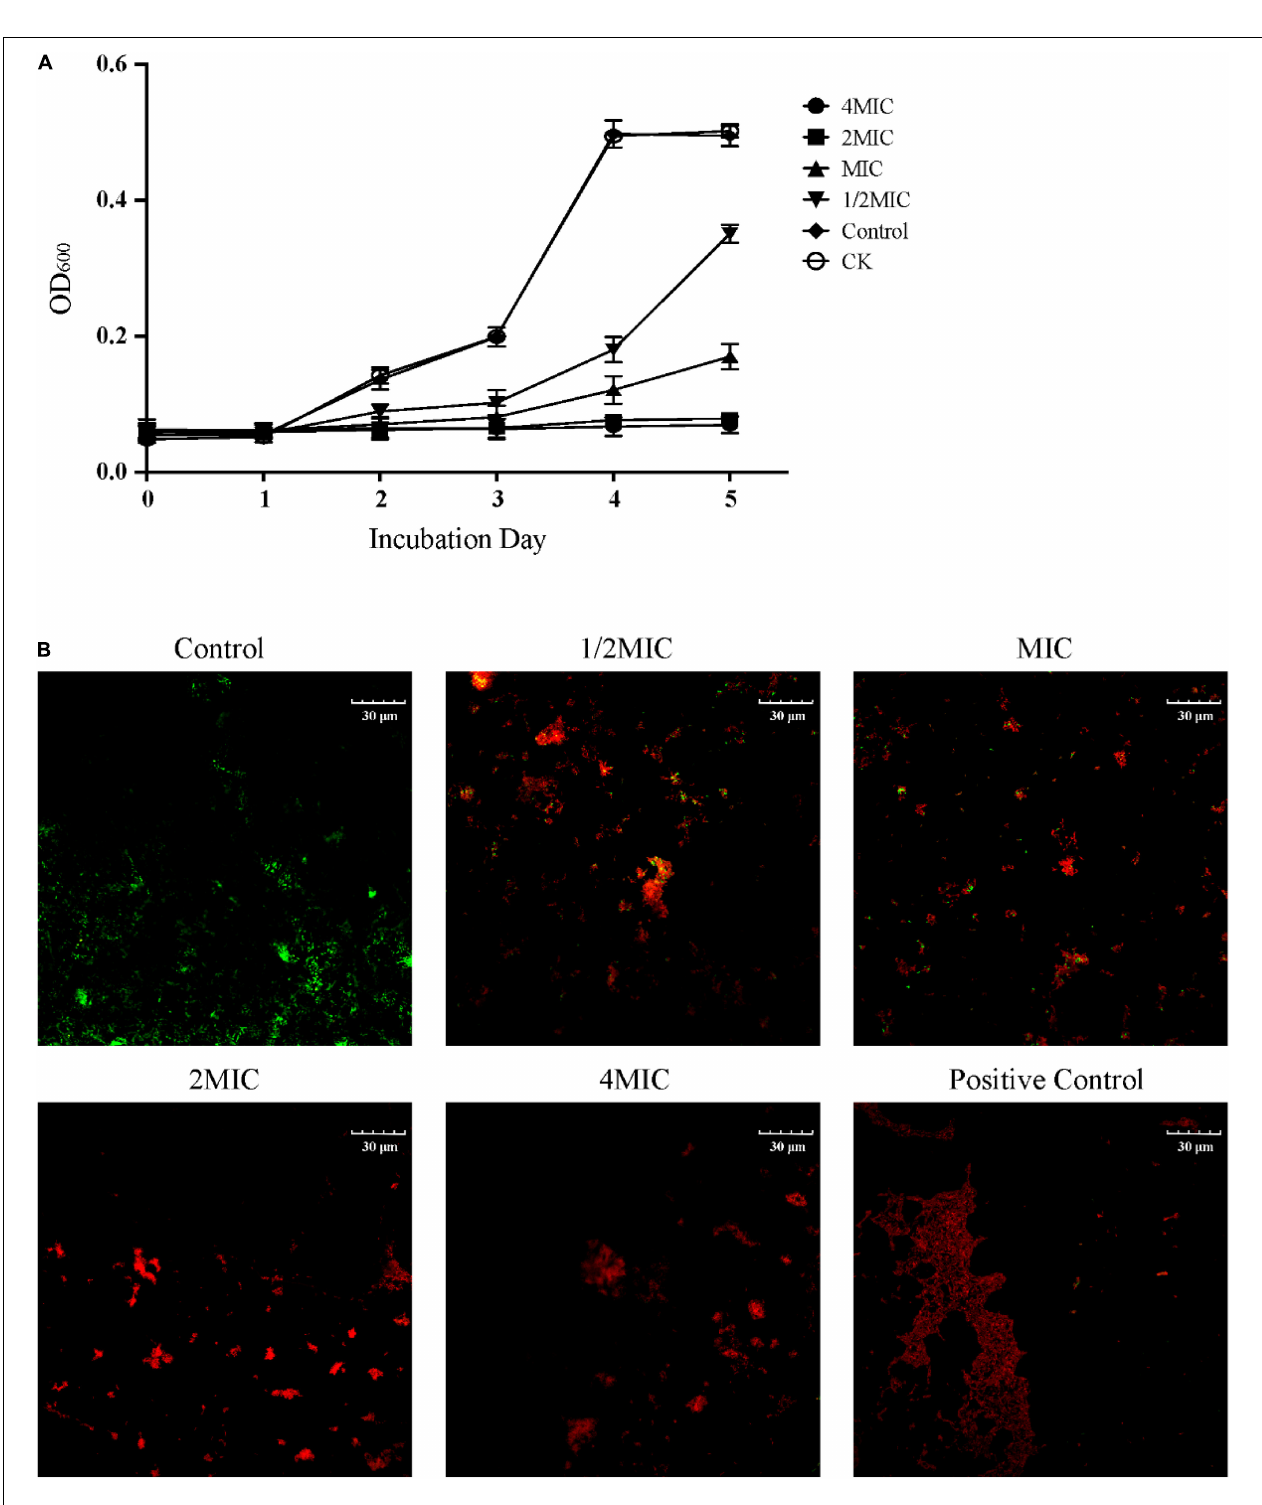
FIGURE 1 | Inhibitory effect of EO on the growth of Cutibacterium acnes . (A) Effect of EO on the growth curve of C. acnes within 5 days. CK represented the blank control group and Control represented the solvent control group by 0.1% Tween 80. (B) Representative Live/Dead merged images (green and red) of C. acnes cultured for 8 h with solvent (Control) and different concentrations of EO (1/2 MIC, MIC, 2 MIC and 4 MIC). The positive control was treated with ethanol. Green fluorescence indicated living cells and red fluorescence indicated dead cells. The positive control was treated with ethanol.